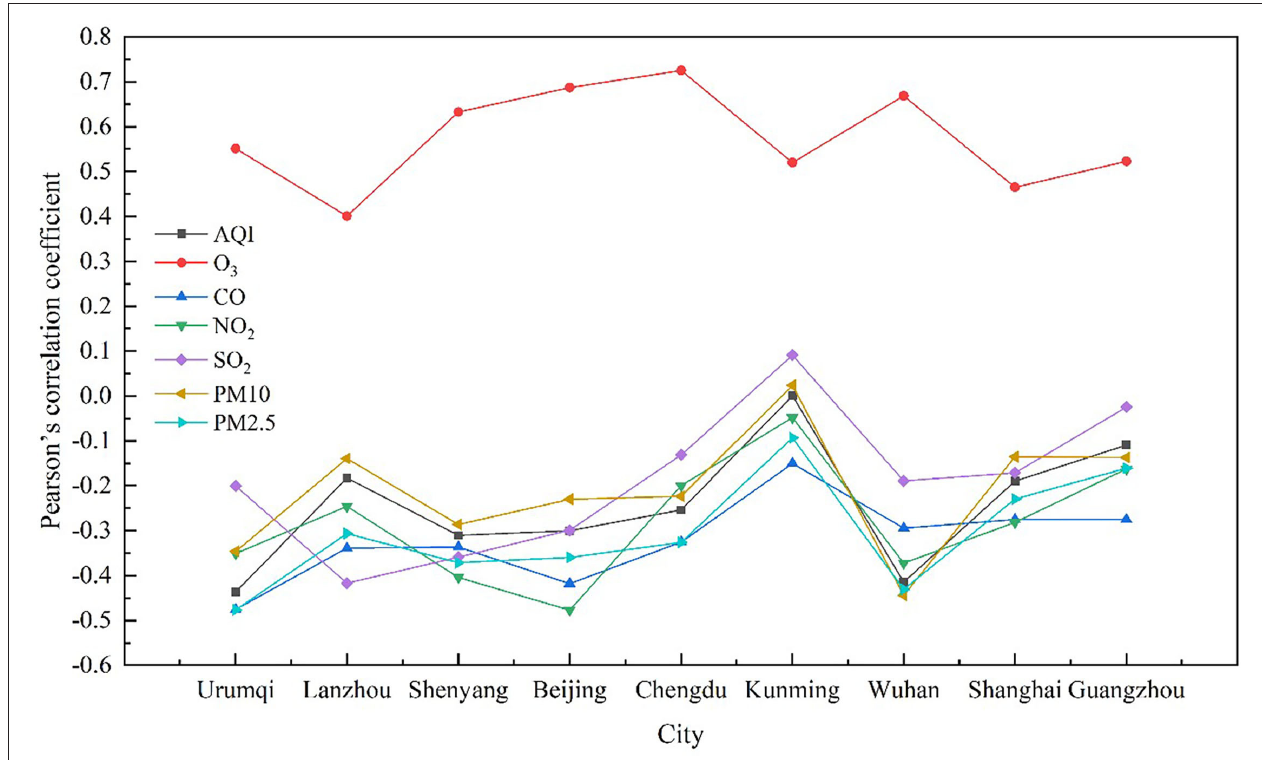
FIGURE 4 | Correlation coefficients between air pollution parameters and daily global solar radiation in the nine cities from 2015 to 2020.